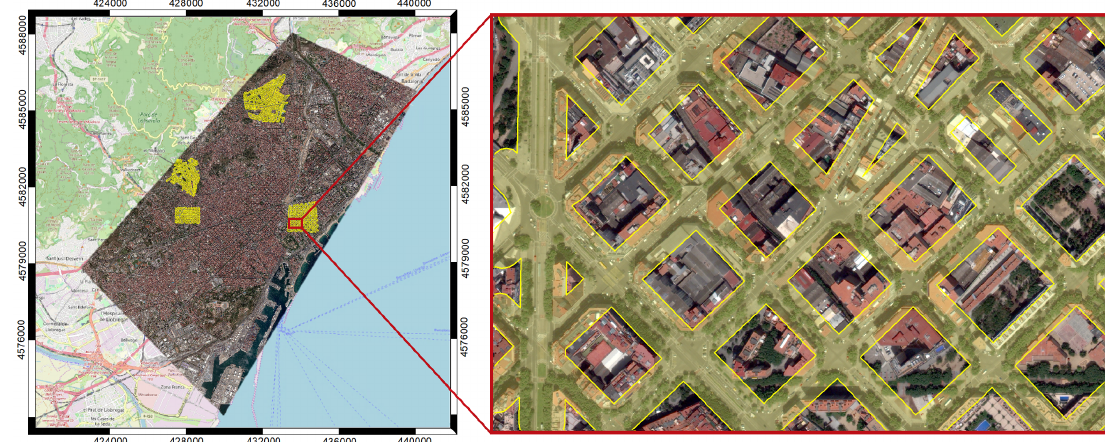
Figure 4. Orthophoto of Barcelona city with highlighted locations of the four ROIs and a detail view, coordinate reference frame: WGS 84/UTM 31N, units =